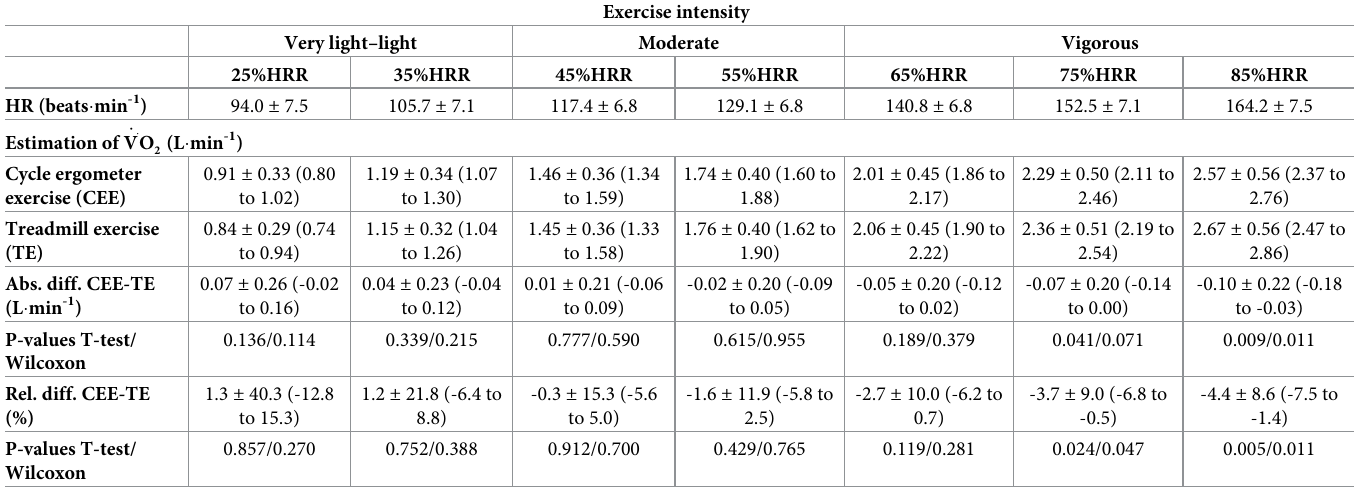
Table 7. Estimation of _ V _ O in model 2, and the absolute and relative exercise mode differences (n = 34, means ± SD, (95% CI) and 2